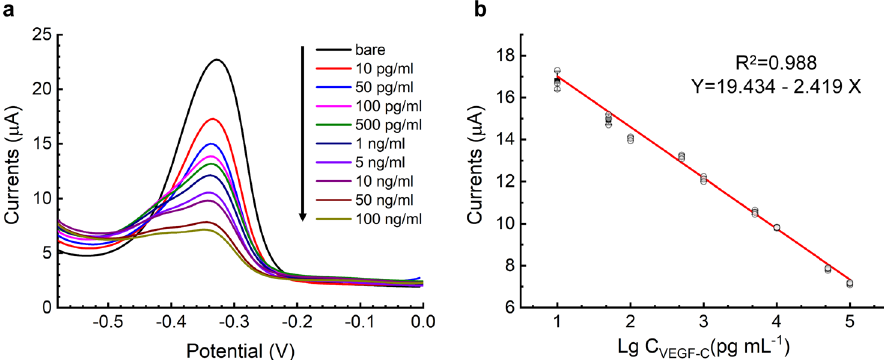
Fig. 5 Assay results of standard VEGF-C solutions in 0.1 M PBS solution (pH = 7.4). a DPV responses of the paper-based device to different concentrations of VEGF-C antigen, ranging from 10 pg mL − 1 to 100 ng mL − 1 . b Calibration curve of the peak current of the DPV response and the logarithm concentration of VEGF-C.